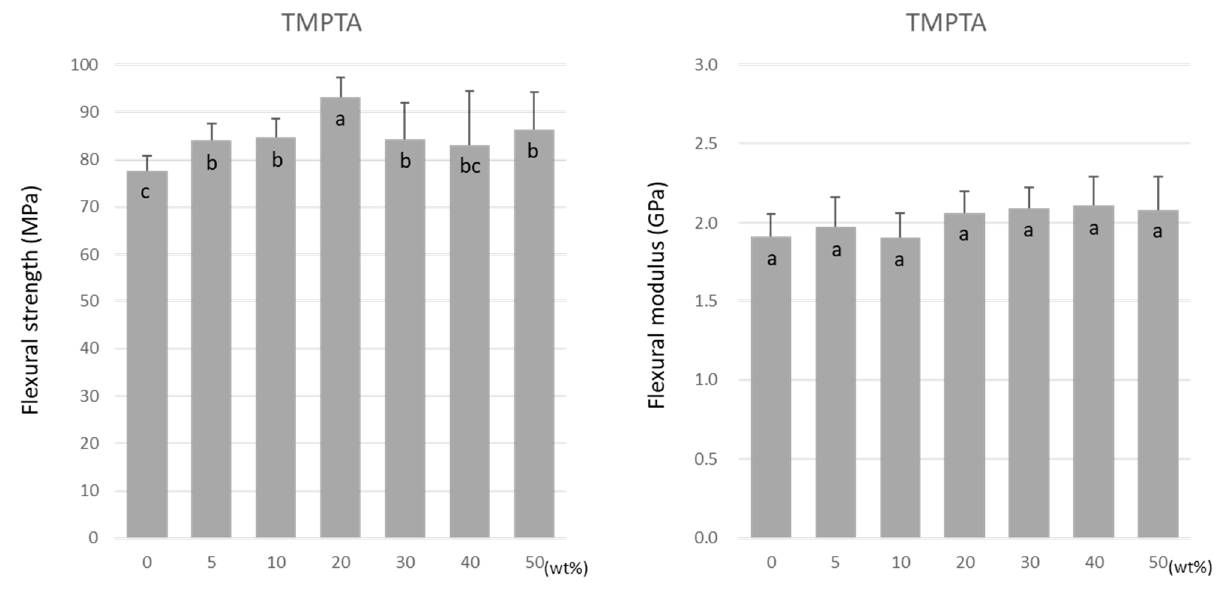
Figure 4. Flexural strength ( left ) and flexural modulus ( right ) of TMPTA. Same letters (a–c) in each column are not significantly different ( p > 0.05).